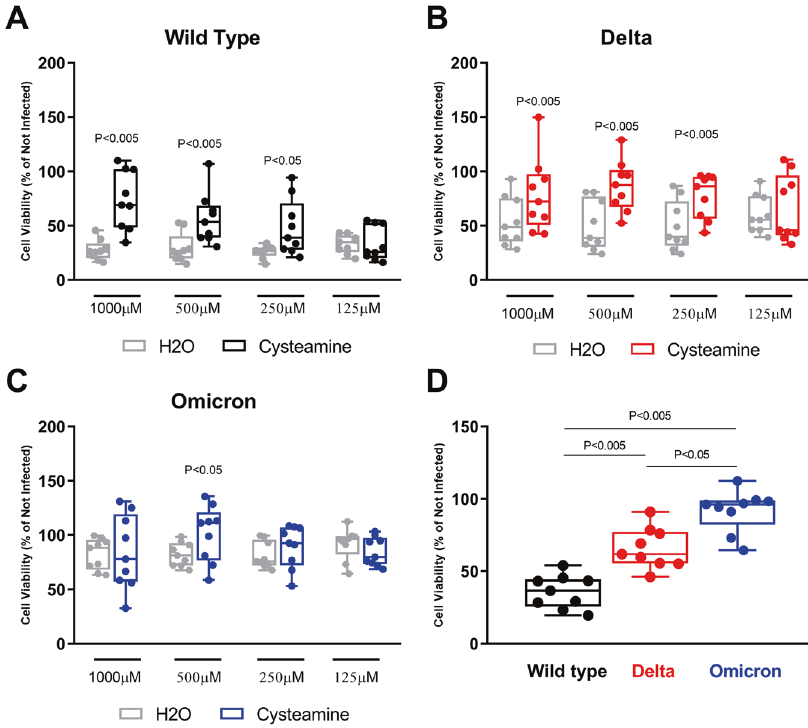
Fig. 1 Cysteamine inhibits CPE induced by SARS-CoV-2 variants in Vero E6 cells. Vero E6 cells were treated with different doses of cysteamine or H 2 O as indicated and infected with SARS-CoV-2 wild type strain ( A ), Delta ( B ), and Omicron ( C ) variants (MOI = 0.001). The percentage of surviving cells was evaluated by crystal violet staining assay 72 h post infection (h.p.i.). The results were reported setting not infected cells as 100% and calculating as a relative value the percentage of not infected cells in the different experimental conditions. ( D ) The different infectious ability of the SARS-CoV-2 variants in Vero E6 cells was expressed comparing the percentage of not infected cells based on the CPE detection. Statistical analysis was performed using Wilcoxon matched-pairs rank test and Friedman test. Data are expressed as median ± S.D. ( n = 9) of three independent experiments performed in